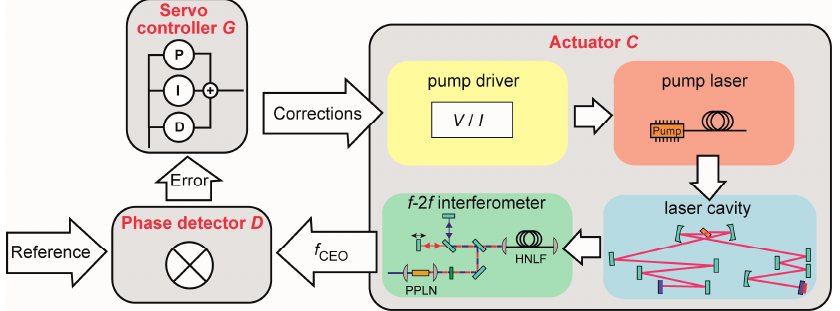
Figure 4. Scheme of principle of a PLL for coherent stabilization of f CEO to an external reference frequency, with its three main components: (i) a phase detector D to measure the phase fluctuation between the signal and the reference to produce an error signal; (ii) a PID servo-controller G that amplifies the error signal; and (iii) an actuator C that tunes f CEO from a control